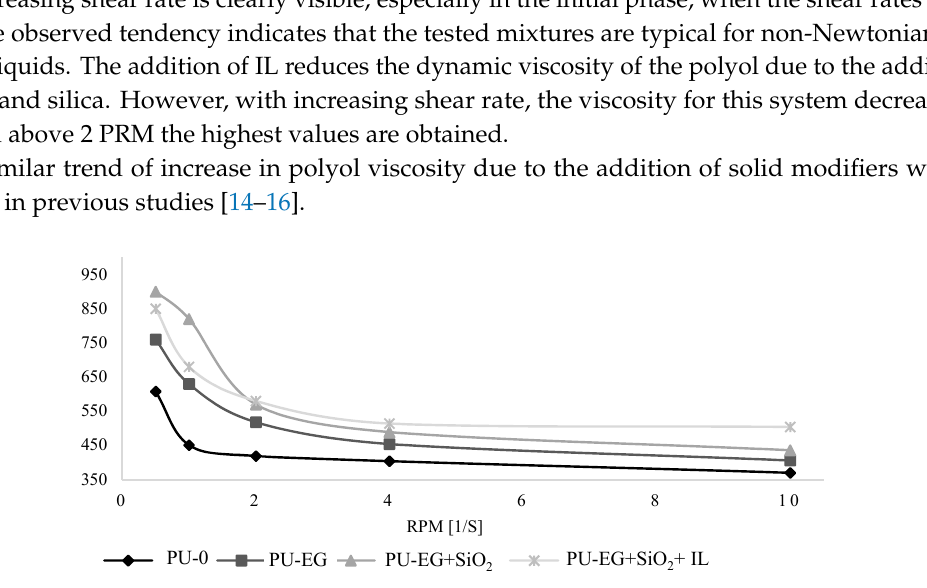
Figure 2. Viscosity of the polyol system modified with graphite, silica and ionic liquid.